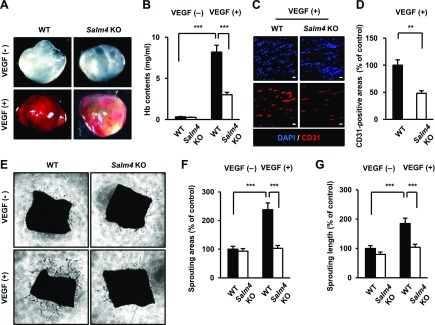
Salm4−/− mice show reduced angiogenic sprouting upon VEGF-A treatment. A) Matrigel plugs were implanted into 6-wk-old WT and Salm4−/− mice. Matrigel was mixed with PBS [VEGF-A (−) group] or 200 ng/ml VEGF-A [VEGF-A (+) group]; n = 7/group. Images show Matrigel plugs at d 7 after implantation. B) Quantification of hemoglobin (Hb) from Matrigel plugs from WT and Salm4−/− mice. C, D) Immunostaining of Matrigel sections: nucleus, DAPI; blood vessels, CD31 (C); quantification of relative CD31-positive areas (D). Scale bars, 20 μm. E) Aortic ring assay of 6-wk-old WT and Salm4−/− mice. VEGF-A was used at 50 ng/ml (n = 7/group). F, G) Quantification of relative sprouting areas (F) and filopodial length (G). Ns, not significant. Error bars represent means ± sd. **P < 0.01, ***P < 0.001 by paired, 2-tailed Student’s t test.